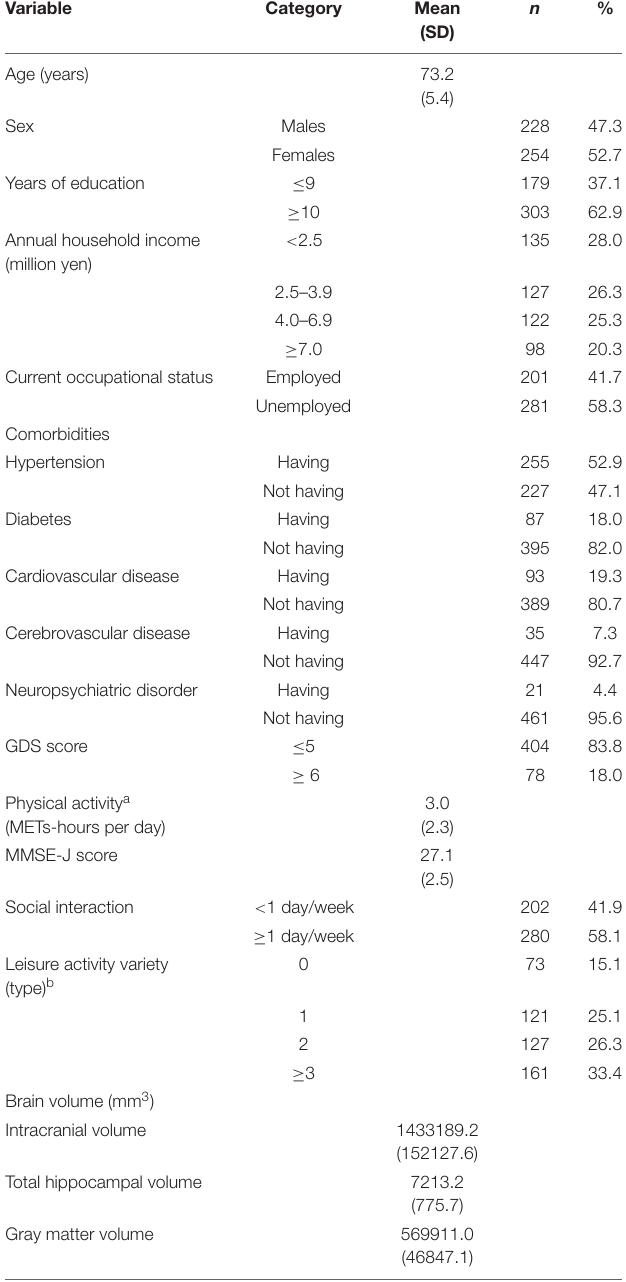
TABLE 1 | Participant characteristics ( N =